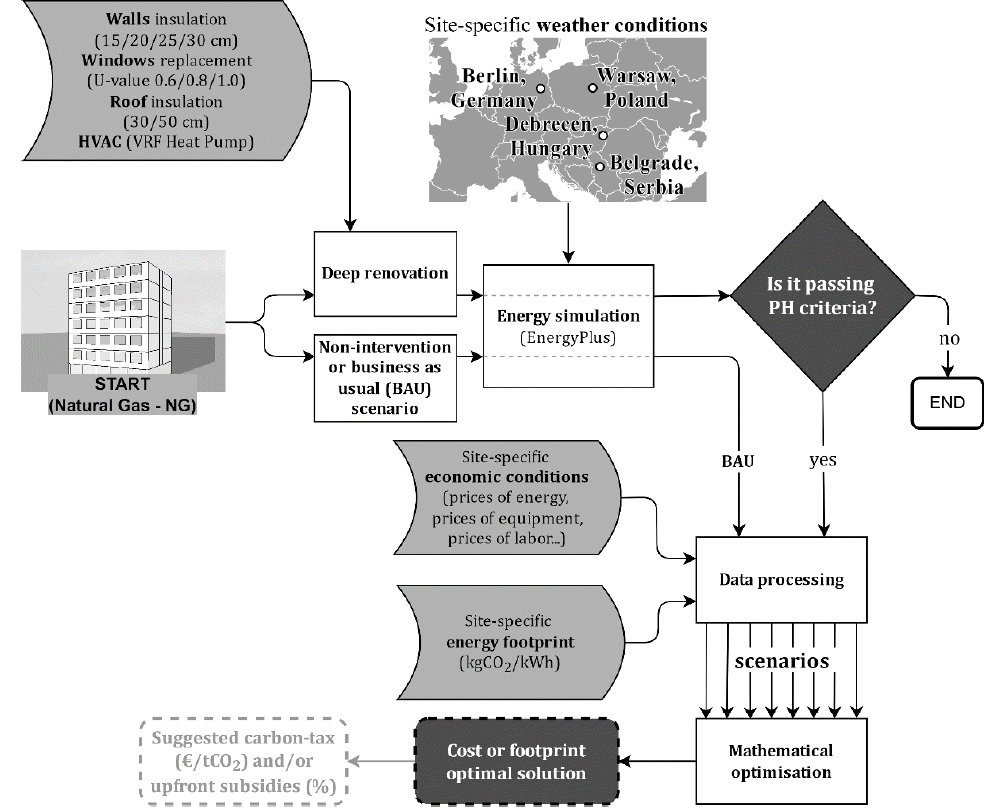
Figure 1. Flow diagram of the proposed optimization methodology.